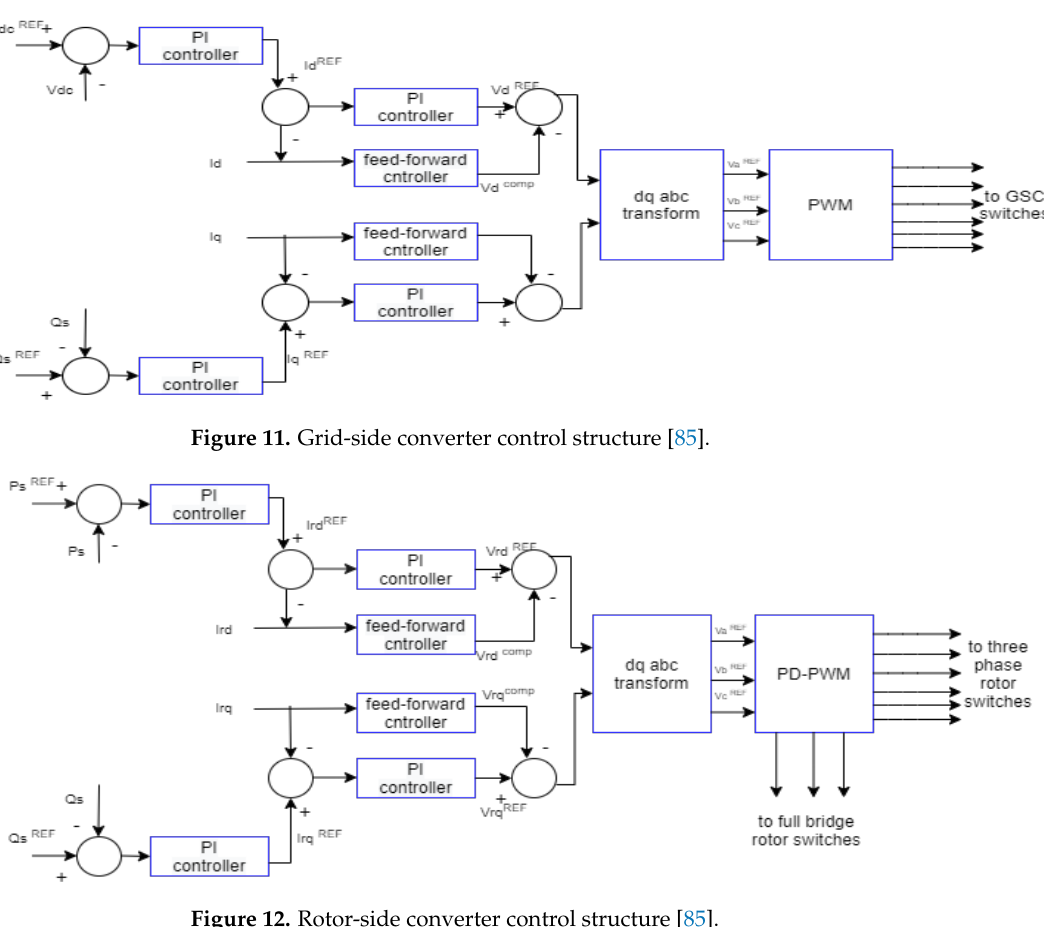
Figure 12. Rotor-side converter control structure [86].